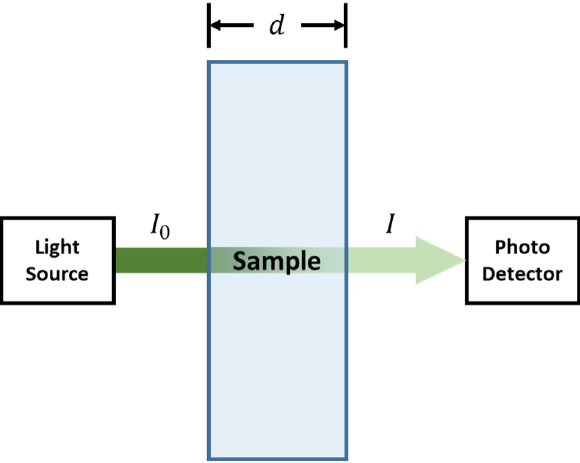
Figure 3. Parameter estimation with the Beer–Lambert